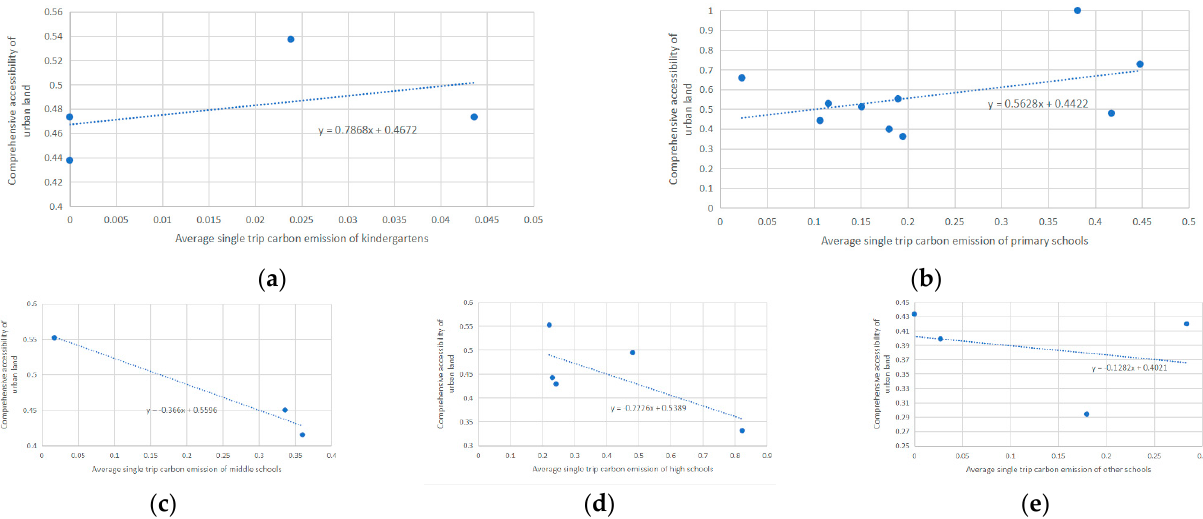
Figure 10. ( a ) Correlation between average single trip carbon emissions of kindergartens and comprehensive accessibility, ( b ) Correlation between average single trip carbon emissions of primary schools and comprehensive accessibility, ( c ) Correlation between average single trip carbon emissions of middle schools and comprehensive accessibility, ( d ) Correlation between average single trip carbon emissions of high schools and comprehensive accessibility, ( e ) Correlation between average single trip carbon emissions of other schools and comprehensive accessibility.